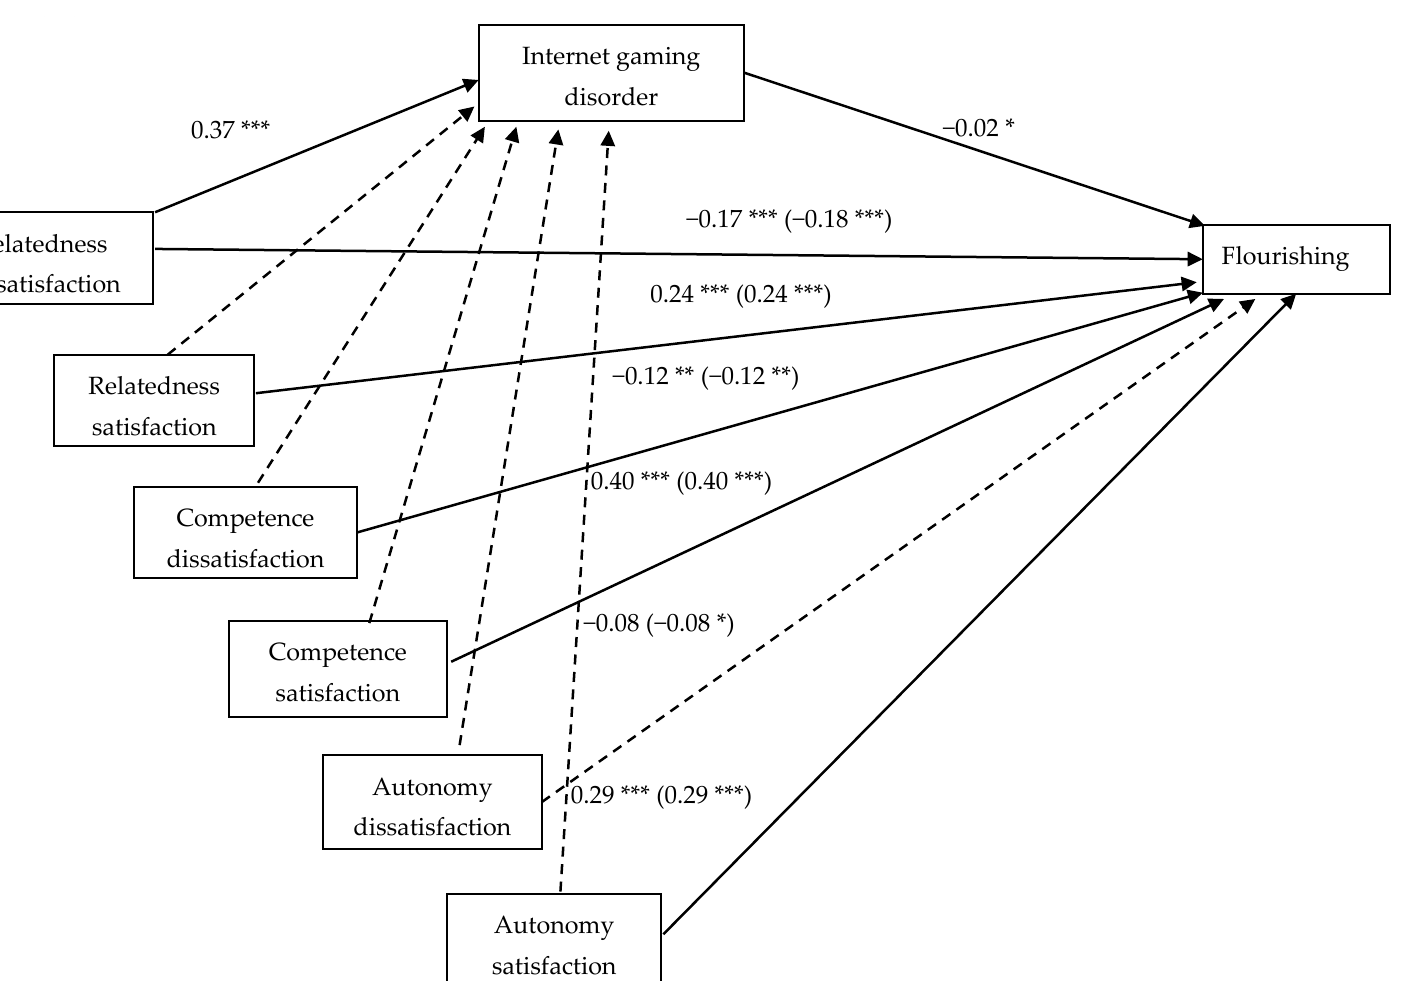
Figure 1. Unstandardized coefficients of a mediation model (controlling for sex, age, hukou, and daily gaming frequency) depicting Internet gaming disorder as a mediator between psychological needs and flourishing. Note. N = 1200. Coefficients in parentheses illustrate the total effect without the mediator. Dashed lines represent a nonsignificant relationship ( p > 0.05). * p < 0.05. ** p < 0.01. *** p < 0.001.